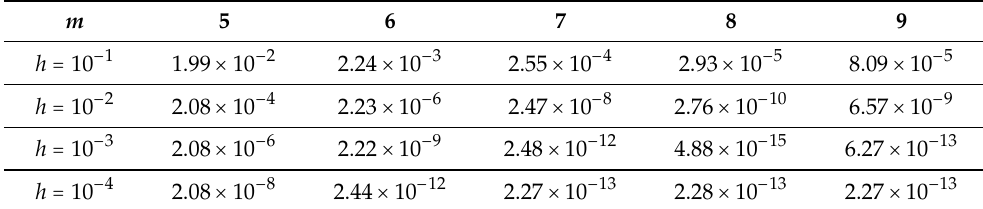
Table 3. Relative errors at b